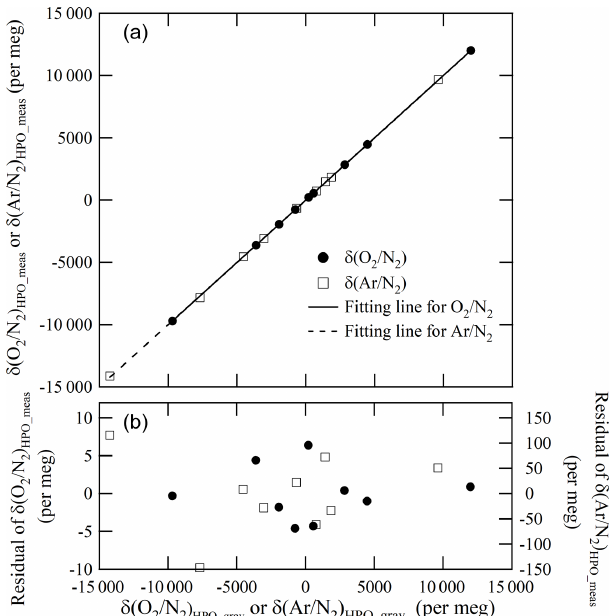
Figure 5. Relationship between δ( O 2 / N 2 ) HPO_grav and δ( Ar / N 2 ) HPO_meas on the AIST scale (a) . Fitting residuals δ( O 2 / N 2 ) HPO_meas and δ( Ar / N 2 ) HPO_meas are likewise shown (b)